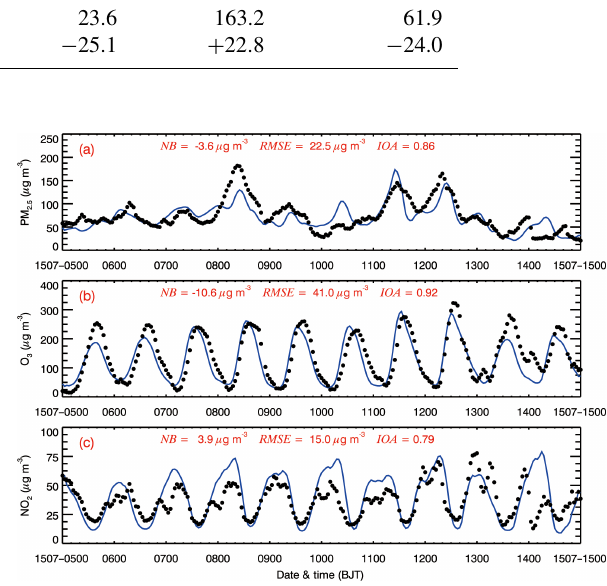
Figure 3. Comparison of measured (black dots) and predicted (blue line) diurnal profiles of near-surface hourly (a) PM 2 . 5 , (b) O 3 , and (c) NO 2 averaged over all ambient monitoring stations in Beijing from 5 to 14 July